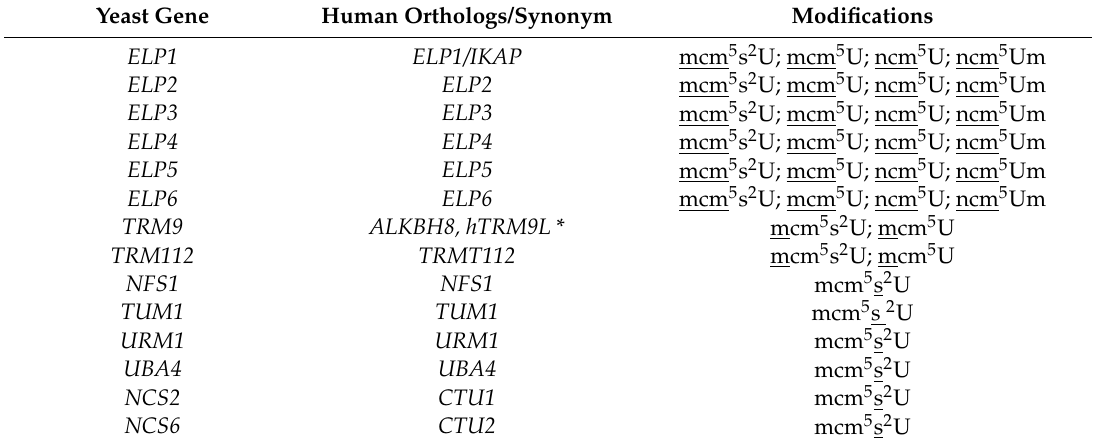
Table 2. Yeast and human genes of the Elongator and ubiquitin related modifier 1 (Urm1) pathways. See text for references. Parts of the modification in which individual genes are involved are underlined.